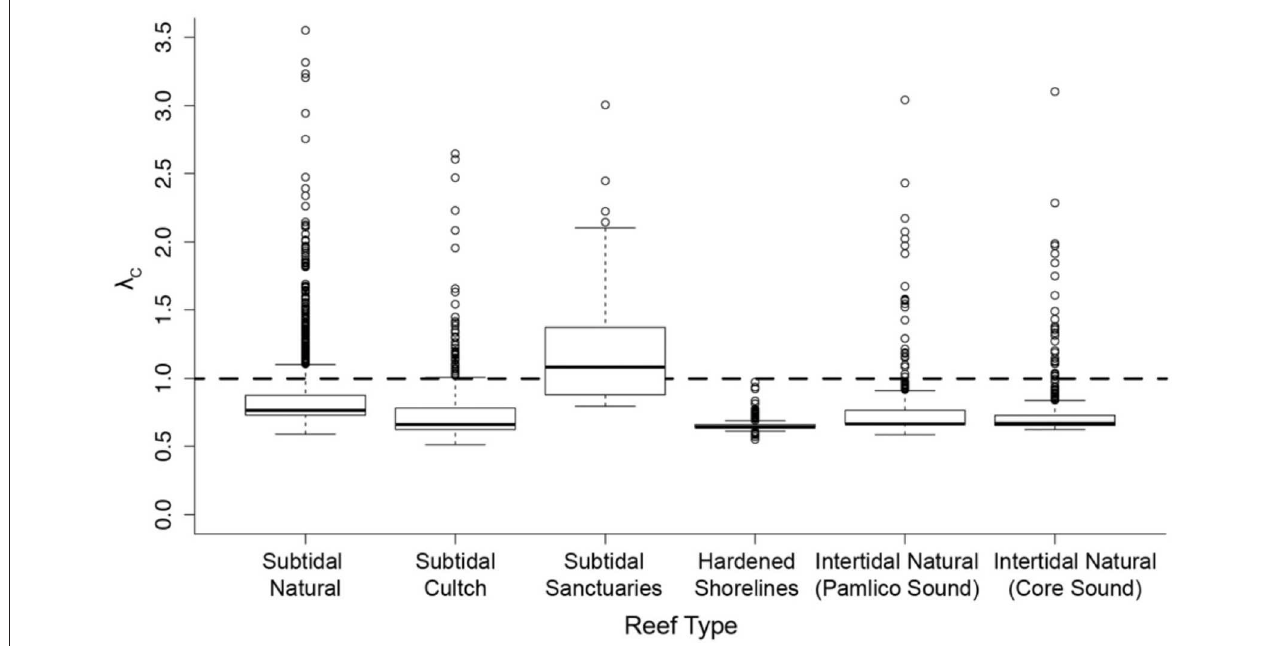
FIGURE 8 | Spatiotemporal variation in metapopulation oyster reef source vs. sink status according to oyster reef type for the eastern oyster Crassostrea virginica . Subtidal cultch (= settlement substrate) reefs are those in which the North Carolina Division of Marine Fisheries (NCDMF) spreads oyster shells or other substrate on the estuarine bottom, followed by natural oyster larval settlement and growth, and harvest by the fishery when oysters reach legal size. Subtidal sanctuaries are oyster reefs generally created by the NCDMF, and are no-harvest, broodstock reefs. Hardened shorelines include pilings, sea-walls and rock rip-rap. Intertidal reefs include those natural intertidal oyster reefs located in two water bodies, each with varying mean demographic rates. Source-sink status ( λ c ) of each reef (by reef type) during each May-June time step between 2012-2016 (assuming larval mortality rate of 10% day − 1 ). λ c ≥ 1 indicates that a given reef functioned as a source during time t , and λ c < 1 as a sink. Figure adapted with permission (S. Theuerkauf, copyright holder) from Theuerkauf